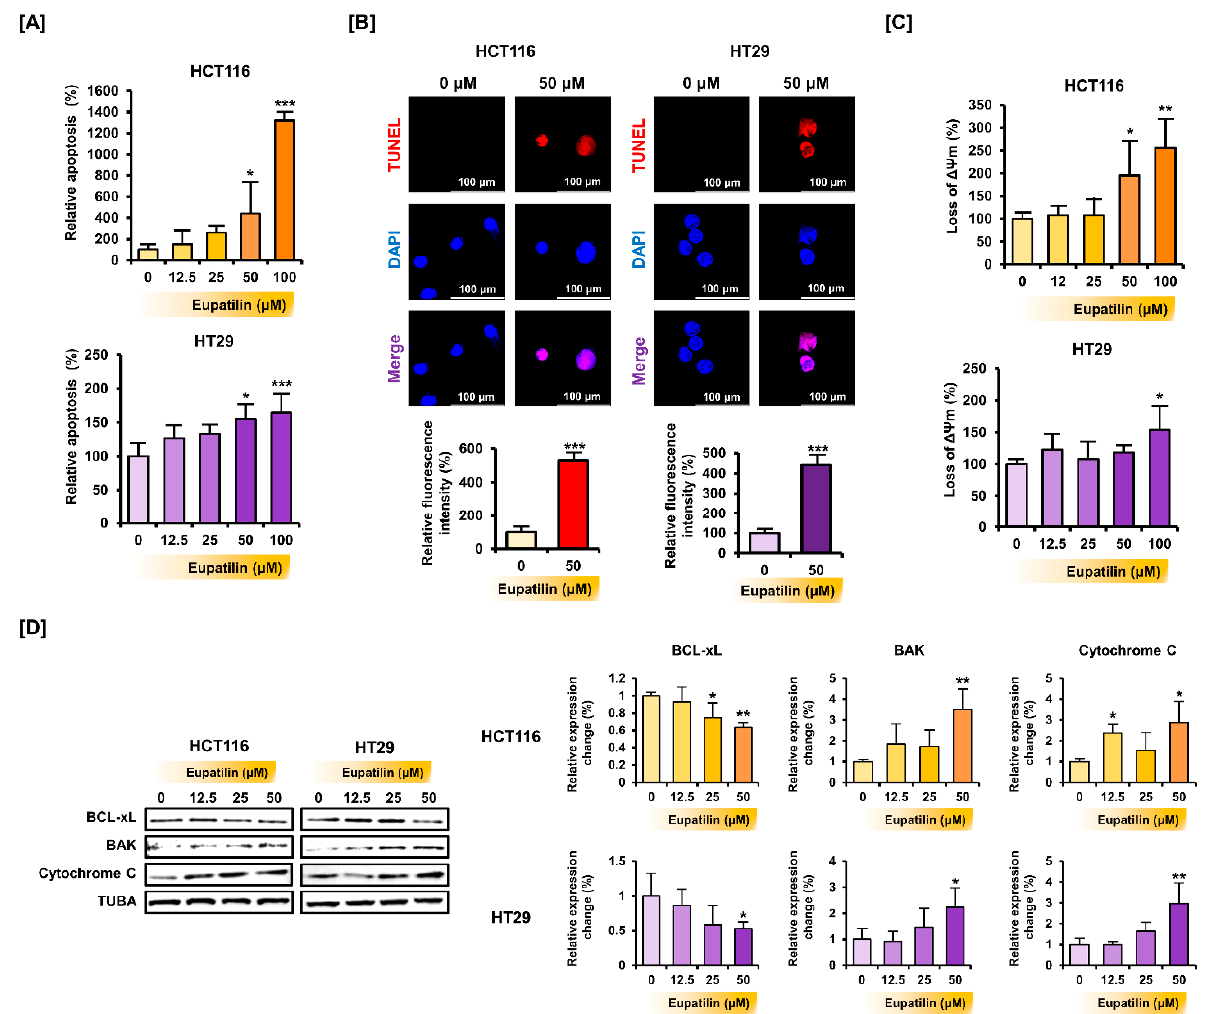
Figure 2. Eupatilin induces apoptosis in colon cancer cells. ( A ) Apoptosis detection in eupatilin-treated HCT116 and HT29 cells. Annexin V and propidium iodide (PI) fluorescence values were estimated by flow cytometry. ( B ) TUNEL fluorescence immunocytochemistry field showed apoptotic cells (red), and the cells were counter-stained with DAPI (blue) ( C ) Mitochondrial membrane potential alteration in eupatilin-treated HCT116 and HT29 cells, detected by flow cytometry. ( D ) Analysis of BCLXL, BAK, and cytochrome c expression after treatment with various eupatilin concentrations for 24 h. Immunoblots were quantitated to calculate normalized values relative to alpha-tubulin (TUBA). Asterisks indicate a significant change after eupatilin treatment (*** p < 0.001, ** p < 0.01, and * p < 0.05).